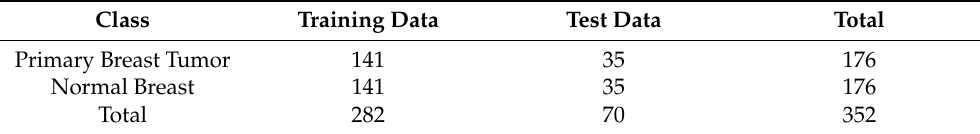
Table 2. The balanced microarray gene expression data is distributed across the training and testing data.